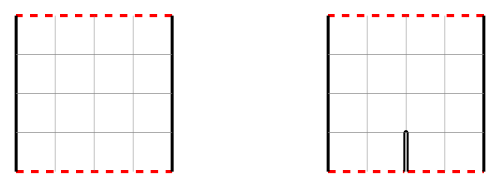
Figure 4 . Half-planes of ( left ) the single-, and ( right ) the double-slit geometries, recast through diffeomorphisms into a linear setting with insulating vs connecting boundaries at right angles. This gives trivial geodesics and a tentative way of identifying more intricate relative